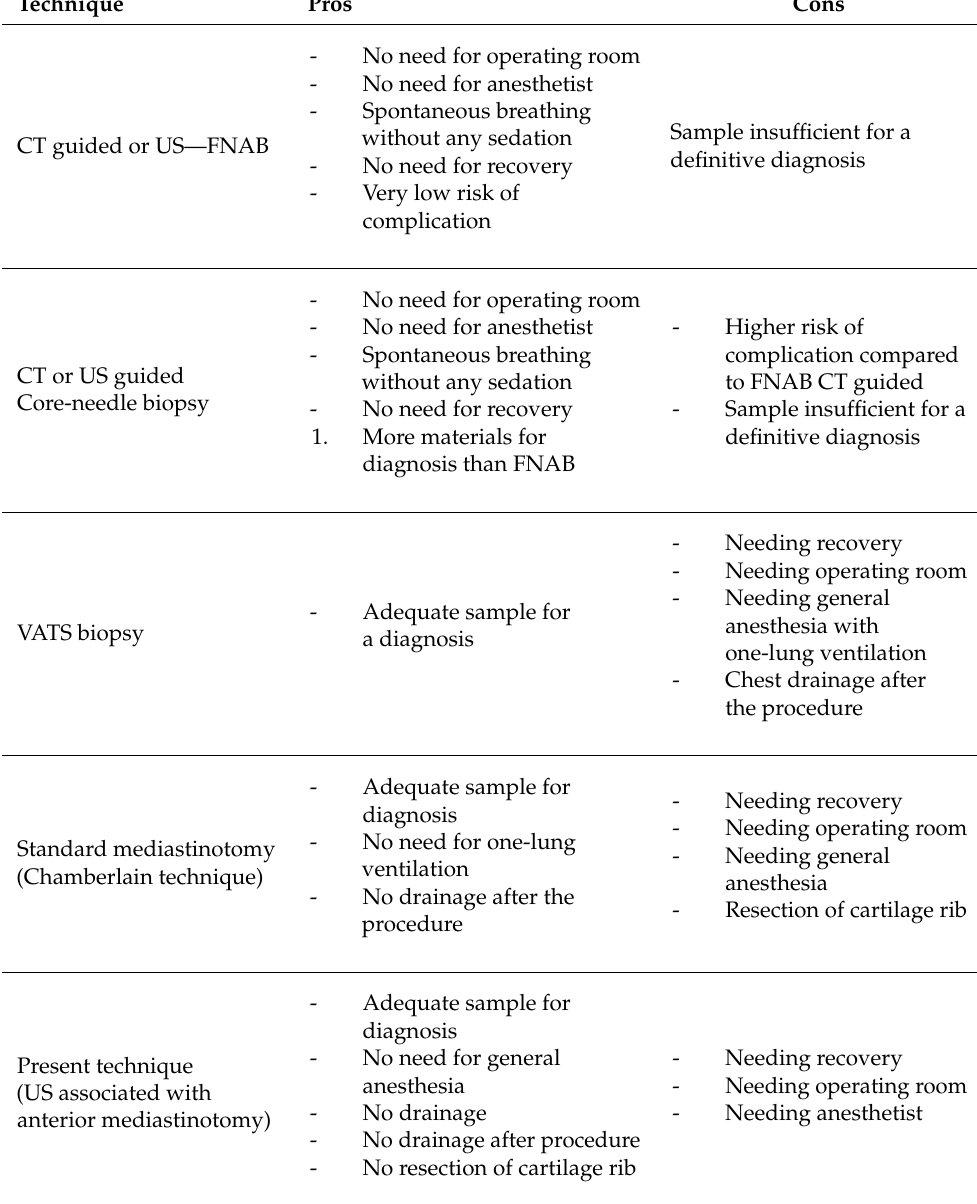
Table 3. Different techniques to sample mediastinal